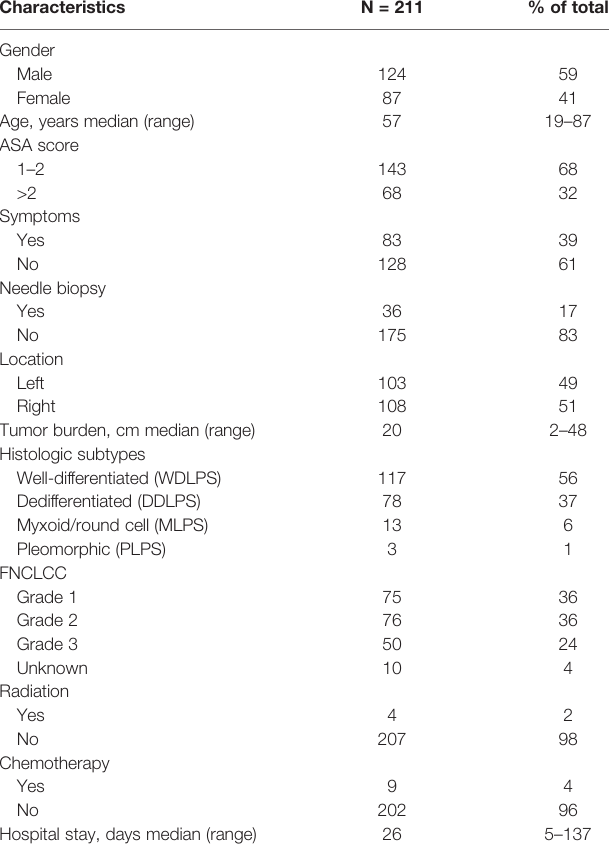
TABLE 1 | Patient and tumor characteristics in 211 patients with primary retroperitoneal liposarcoma.